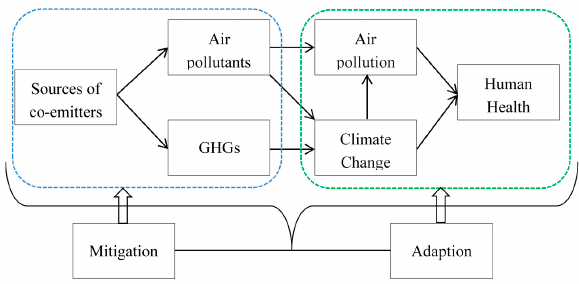
Figure 1. Pathway of the health co-benefits of greenhouse gas mitigation measures.